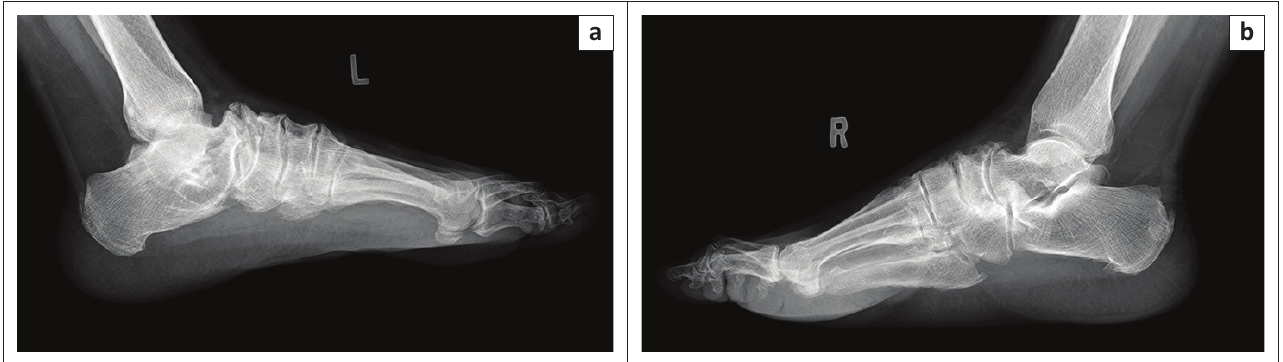
FIGURE 5: Lateral radiographs (a and b) of both feet in an HIV-positive patient. The radiograph demonstrates periostitis and enthesitis affecting the right foot more than the left foot.